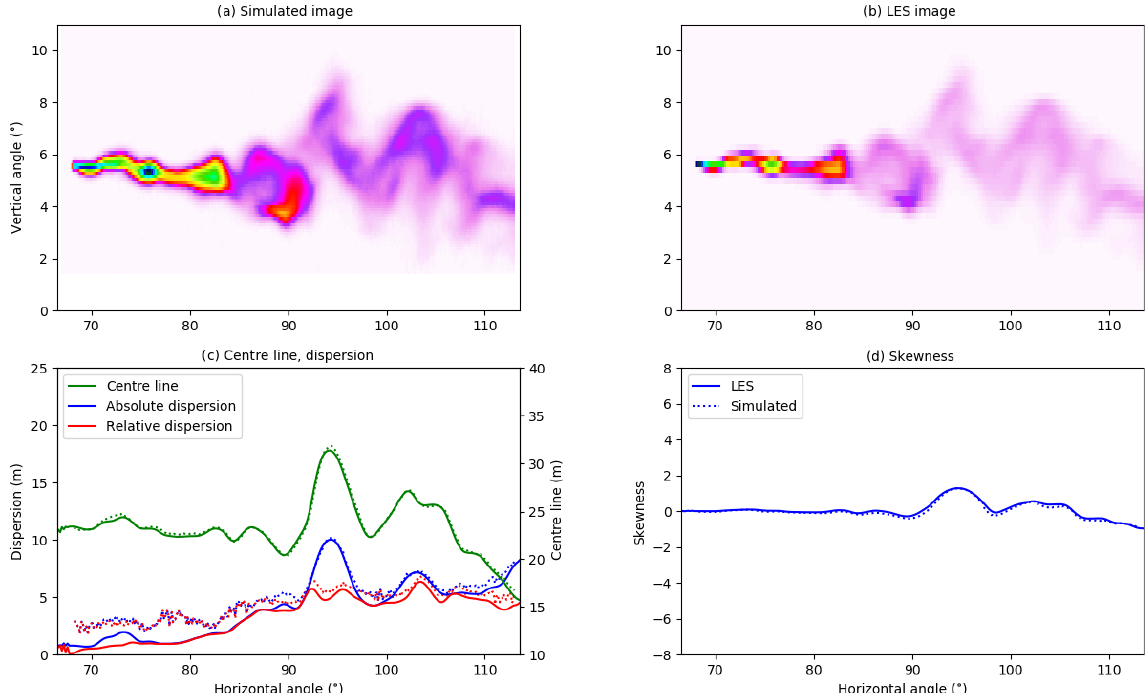
Figure 4. (a) The plume apparent absorbance for camera A from Fig. 3c. (b) The LES column density integrated along the line of sight. Colour scales in (a) and (b) are relative and thus no colour bars are provided. (c) The centre line, absolute, and relative dispersions. (d) The